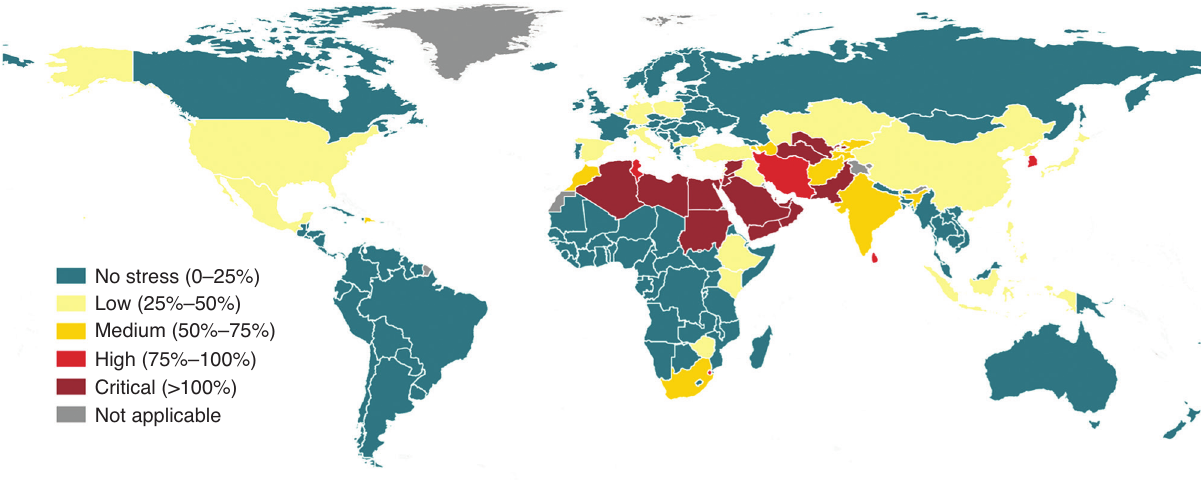
Figure 1 SDG 6.4.2 level of water stress (in percentage) at country level, based on the official statistical data available in AQUASTAT (reference year 2018). Geographic